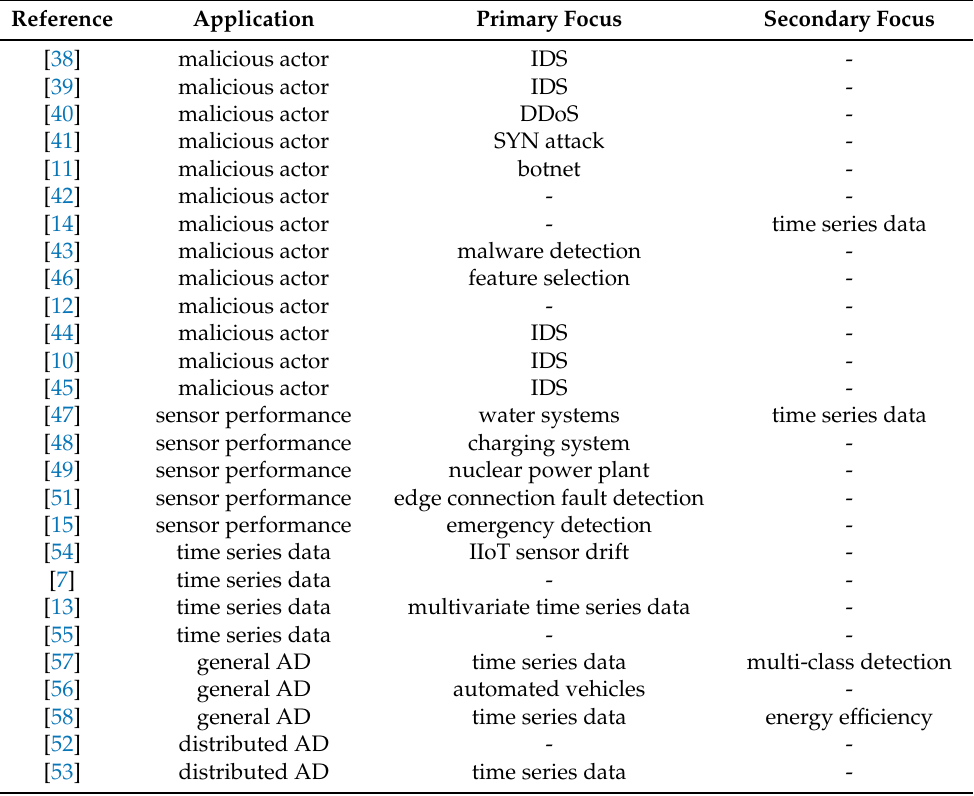
Table 2. Breakdown of application types for IoT-based